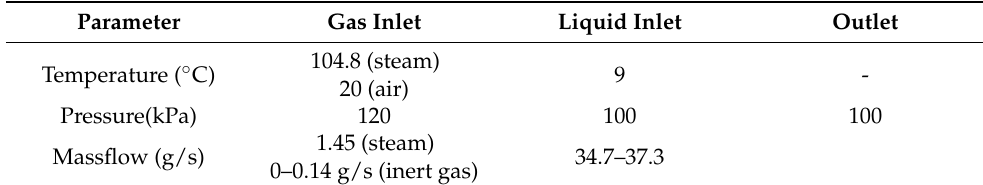
Table 22. Simulation parameters from Zhang et al.